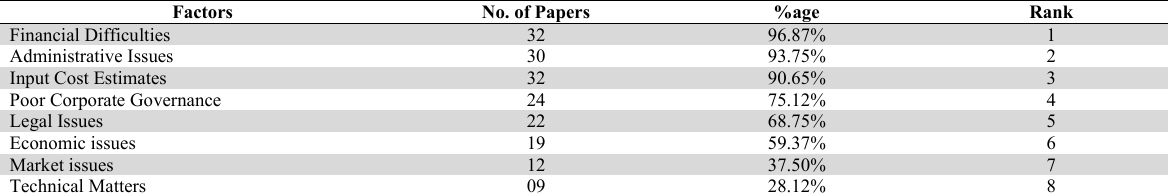
Ranking of the Relevant